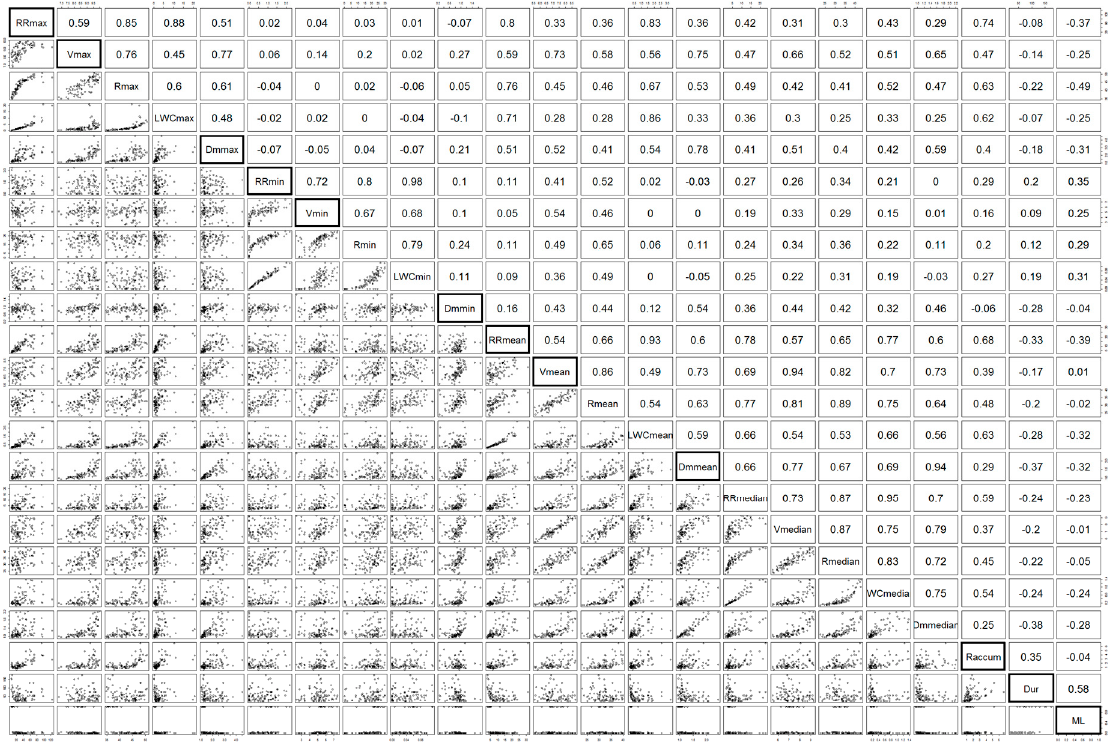
Figure A1. Cross-correlation matrix between rainfall characteristics. The highlight characteristics are the features selection for the algorithm.